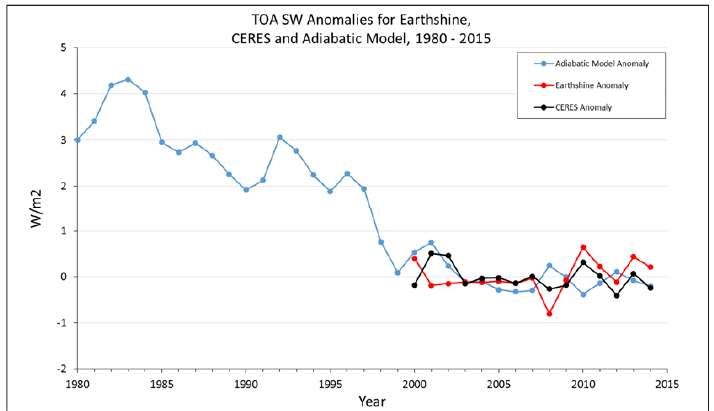
Figure 8. Top of atmosphere shortwave radiation anomalies, expressed in W/m 2 , for the adiabatic model (compared to 2000–2014 average), CERES (compared to 2000–2016 average), and earthshine (compared to 1998–2014 average) [22] datasets.